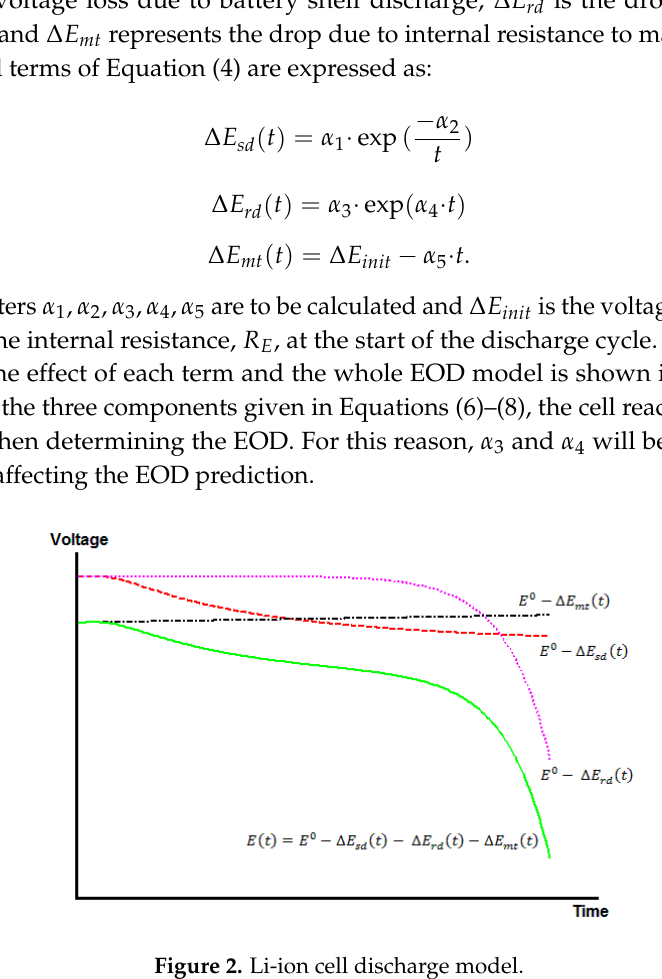
Figure 2. Li-ion cell discharge model.